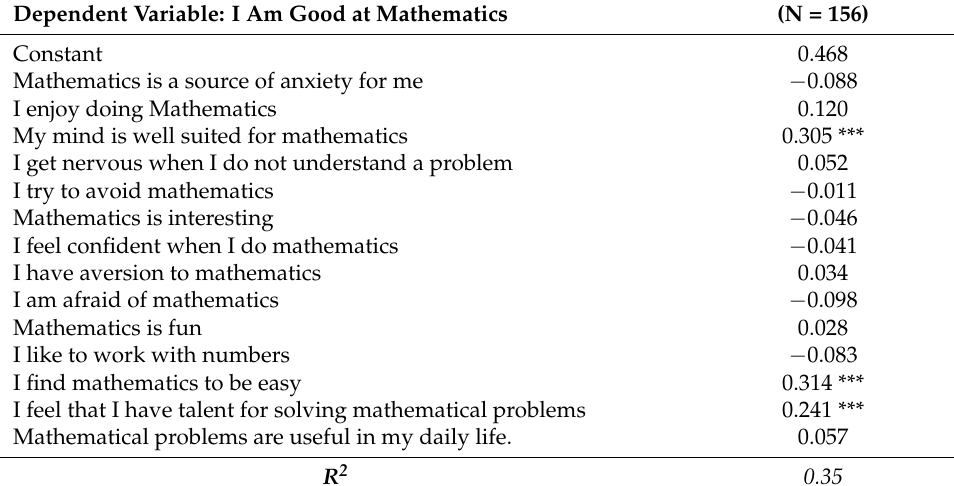
Table 2. Supporting regression for the index of non-cognitive